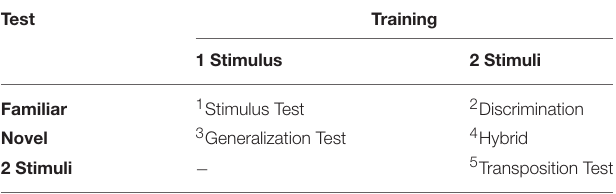
TABLE 1 | Learning